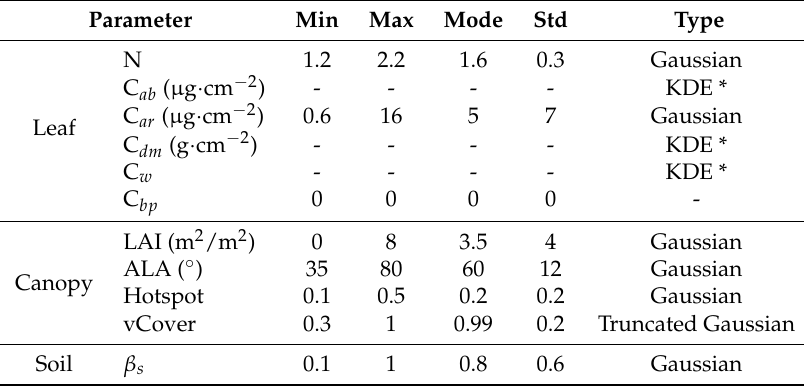
Table 3. Distributions of the parameters within the PROSAIL RTM at leaf (PROSPECT-5B) and canopy (SAIL) levels. * KDE refers to kernel density estimation method, which does not provide any parameters being a non parametric model of the marginal